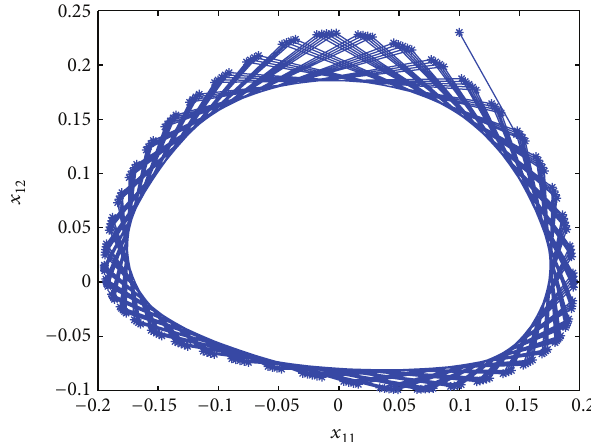
Figure 4: Phase response of state variables 𝑥 11 , 𝑥 12 in Example 2.